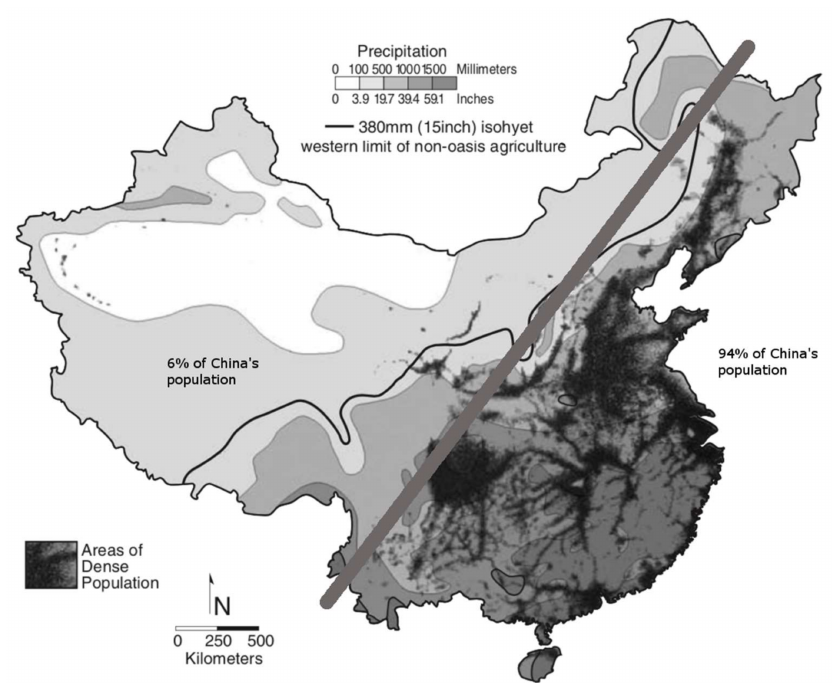
Figure 1. Precipitation and human population in China; showing precipitation isopleths (shading) and highly concentrated areas of human population. Areas north and west of the solid line cannot support agriculture in the absence of irrigation, and hence qualify as “western China.” The majority of China’s people resides in the eastern half of the country. Adapted from [34], used with permission. Encompassing around one-quarter of China’s land area—or 2.5 million km 2 —and with an average elevation over 4000 m above sea level (asl), the Tibetan Plateau is the largest and highest mountain area in the world. While China itself is recognized as one of the most